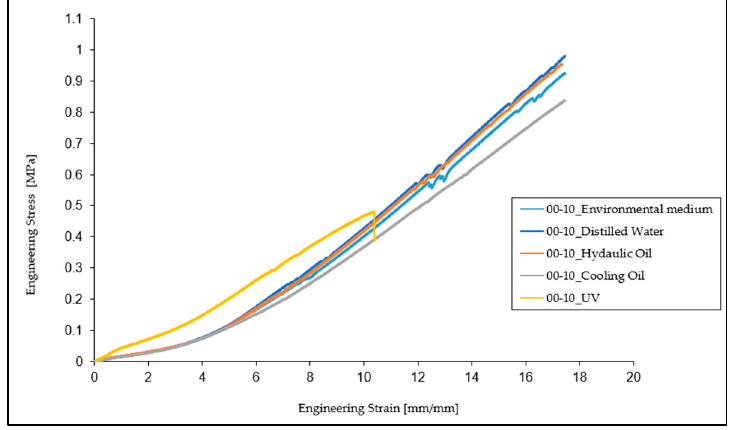
Figure 7. Average of the five specimens tested for Ecoflex 00-10 in the five environments.